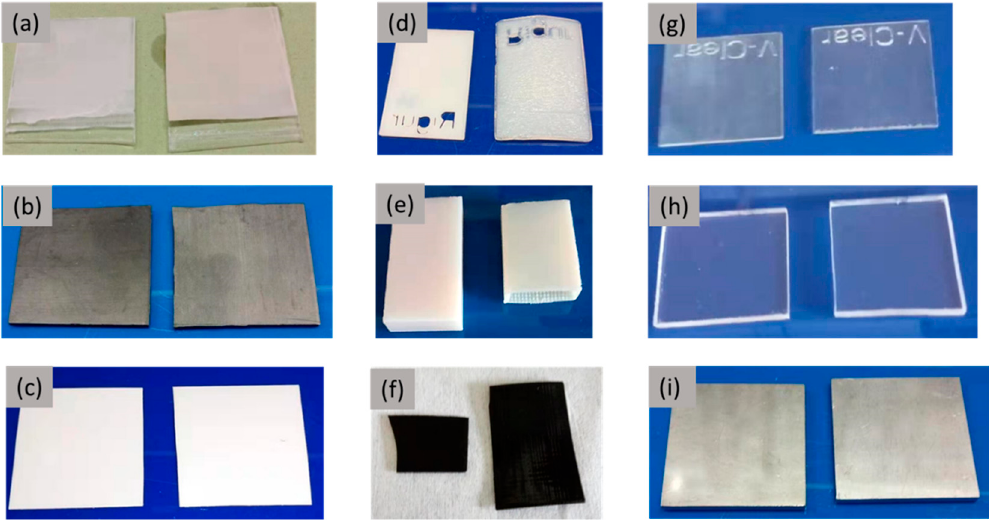
Figure 2. Photographic images showing the effect of immersion treatment, in 1.0 M KOH held at 60 °C for 7 days, on several sealing and encasement materials that could be used for PEC devices. The specimens are arranged with the initial state and the exposed state on the left and right, respectively. ( a ) LOCTITE ® EA 9492 non-conductive adhesive on glass, ( b ) EPDM, ( c ) Coveme Tedlar Dymat ® PV backsheet, ( d ) 3-D printed polypropylene based, Rigur, ( e ) Objet RGD525 HT, ( f ) VeroBlack, ( g ) 3-D printed PMMA derivative (VeroClear), ( h ) bulk PMMA ( i ) 316L stainless steel. The starting materials for all 3-D printed polymers in ( d ) to ( g ), inclusive, are manufactured by Stratasys.